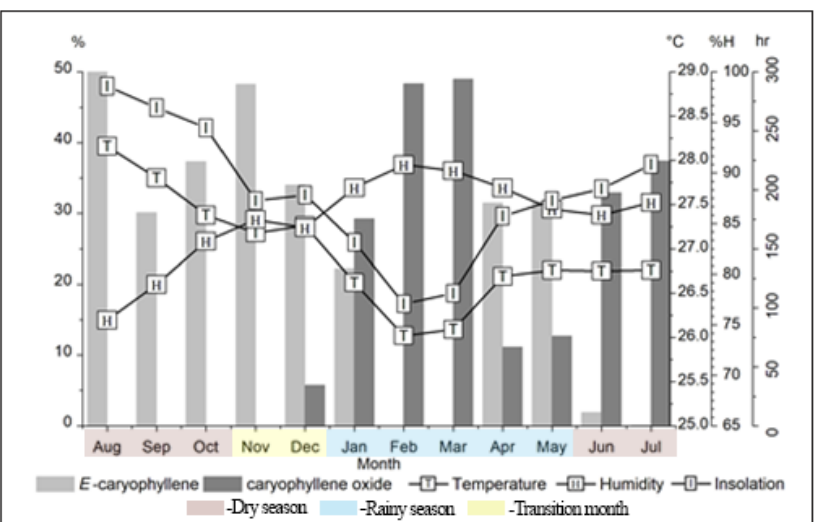
Table 2. Correlation of E. patrisii essential oil primary constituents with the collection site climatic parameters.